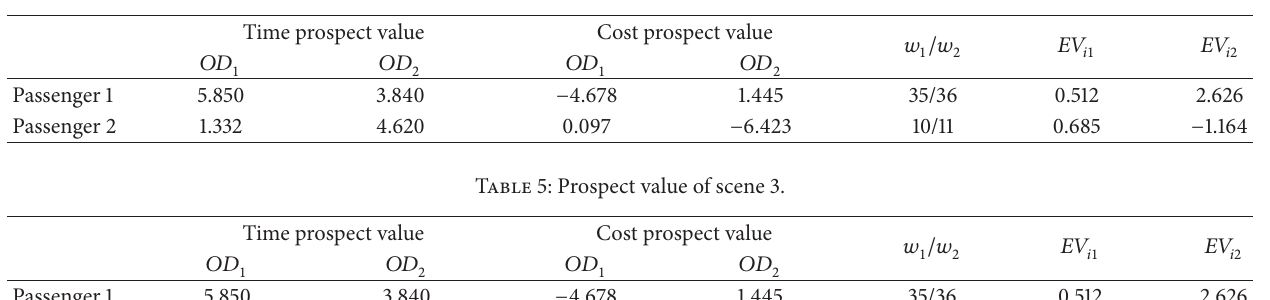
Table 4: Prospect value of scene 2.